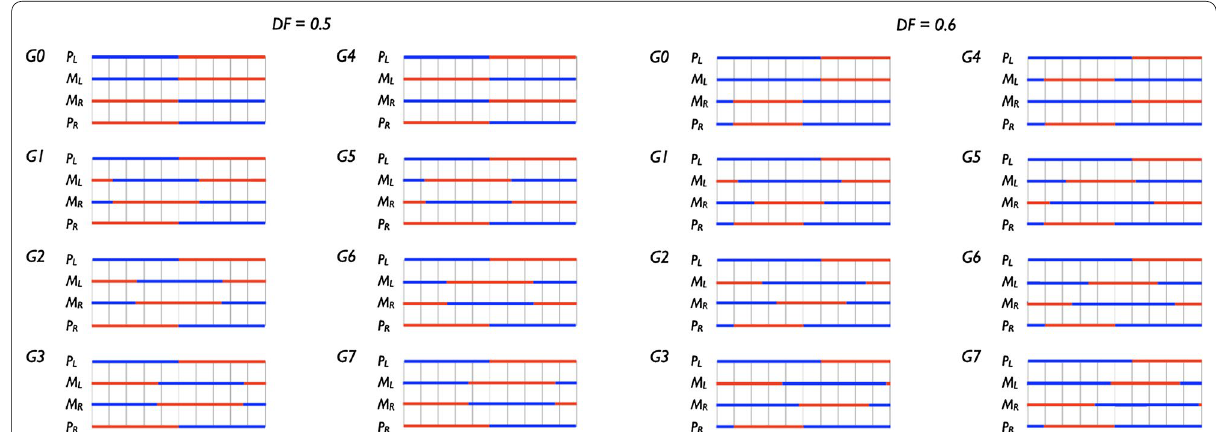
Fig. 2 The step cycles for gaits G0 – G7 are plotted for a duty factor DF indicates transition. For DF 0.6 only G0 and G4 provide intervals with four limbs simultaneously in support =